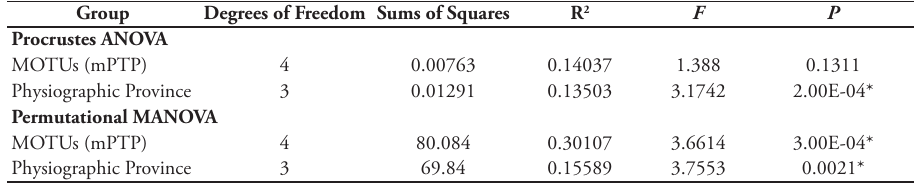
Table 4. Results from both TM and GM analyses. Asterisk (*) denotes significant p-values. Group Degrees of Freedom Sums of Squares R 2 Procrustes